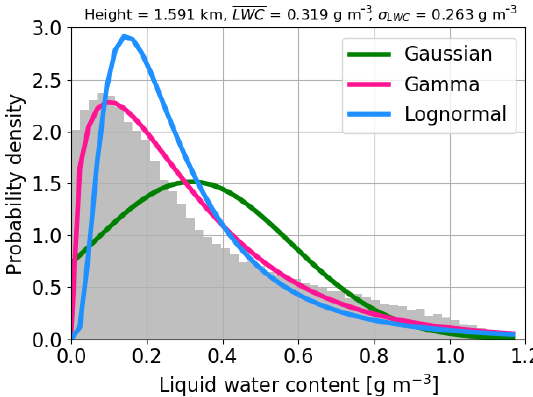
Figure 14. Actual LWC probability density in the central part of the cloud layer and distributional